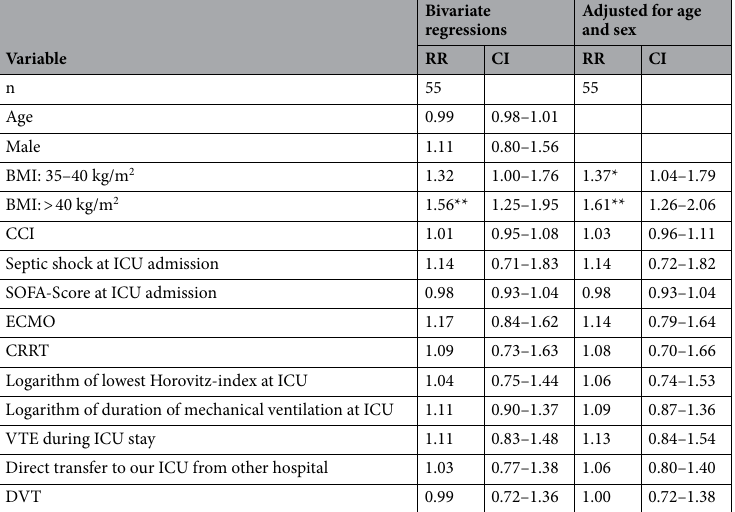
Table 8. Relative risk regressions for Long-COVID. Relative risks with 95%-confidence intervals for Long- COVID from robust Poisson regressions (significance levels: * = 5%, ** = 1%). BMI Body-Mass-Index, CCI Charlson ComorbidityIndex, CI Confidence interval, CRRT Continuous renal replacement therapy, DVT Deep vein thrombosis, ECMO extracorporeal membrane oxygenation, ICU Intensive care unit, RR Relative risk, VTE Thromboembolic